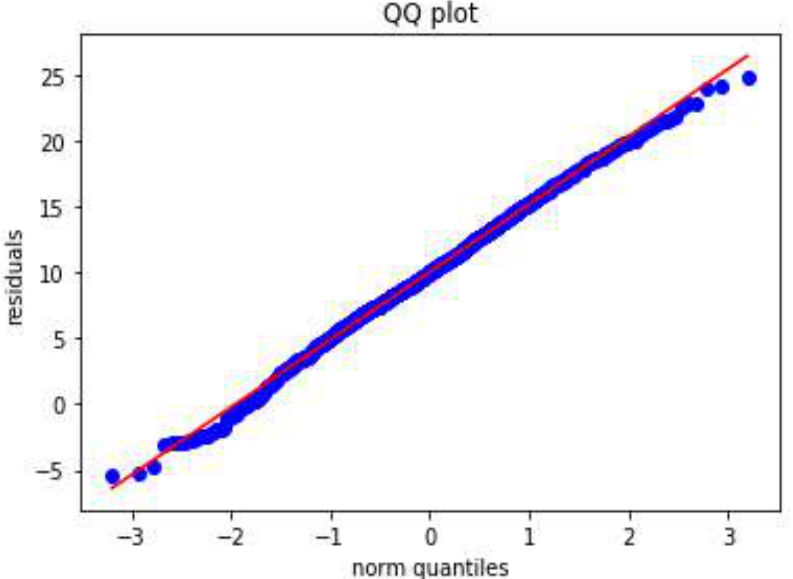
Figure 21. QQ plot (red line showing 45 degrees) shows data variability along the normal quantile distribution.